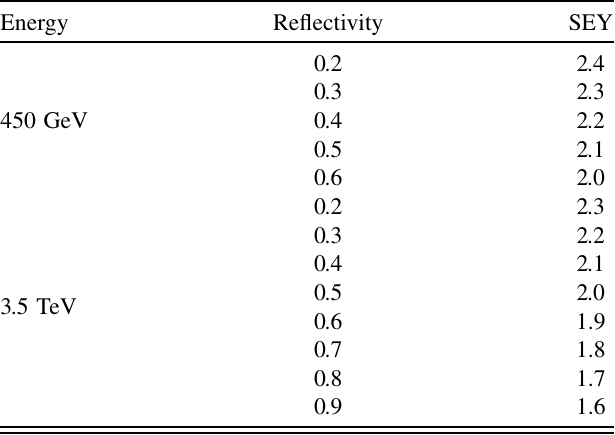
TABLE V. Summary of multipacting thresholds for a dipole section of sets A and B (50-ns bunch spacing).